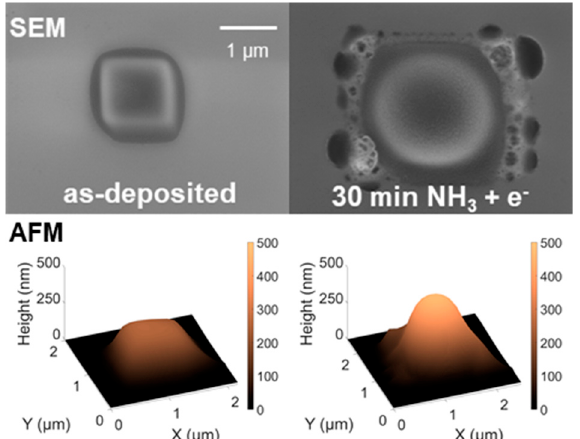
Figure 1. Scanning electron microscope (SEM) ( top ) and atomic force microscope (AFM) ( bottom ) images of a 1 × 1 µm 2 deposit fabricated by focused electron beam-induced deposition (FEBID) from (EtCp) 2 Ru on a SiO 2 /Si substrate ( left ), and of the deposit after post-processing under 30 min electron irradiation at 5keV in an atmosphere of 0.11 mbar NH 3 ( right ). The scale bar applies to both SEM images.